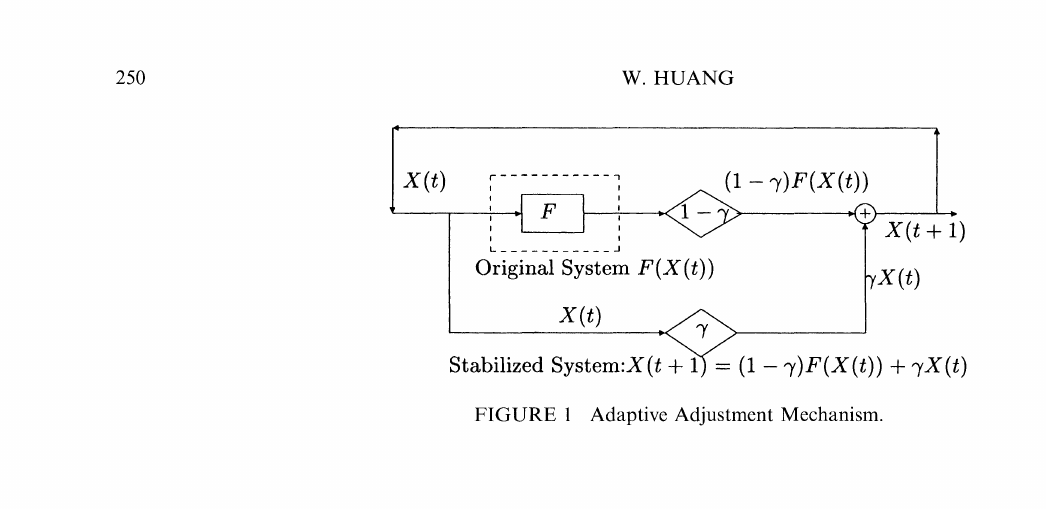
FIGURE Adaptive Adjustment